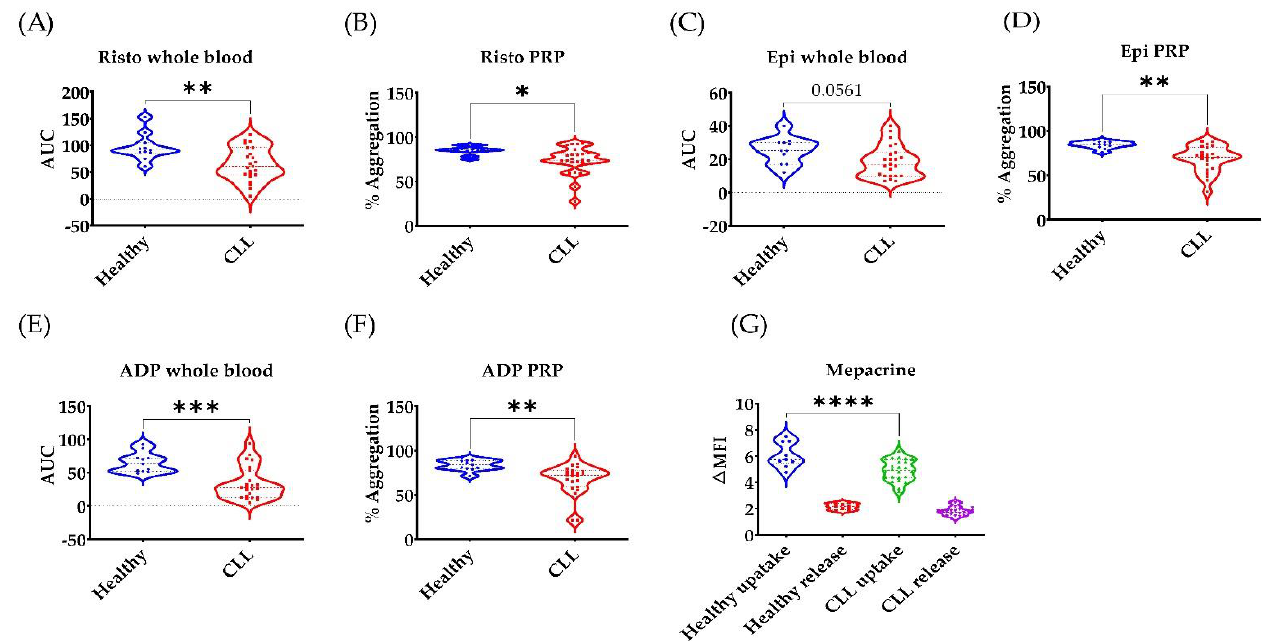
Figure 2. Broad reduction in CLL platelet response to several agonists. ( A – F ) Impaired platelet response to ristocetin, epinphrine and ADP in whole blood and PRP. ( G ) Reduced mepacrine uptake in CLL platelets compared to health volunteers. * p < 0.05, ** p < 0.01, *** p < 0.001, **** p < 0.0001; n = 23 CLL patients and 11 age-matched healthy volunteers. Platelet aggregation in PRP was measured by LTA using ristocetin: 1.2 g/L, epinephrine: 7 µM, and ADP 4 µM. Whole blood aggregation was measured by MEA using risotcetin 0.7 g/L, ADP 6.4 µM and epinephrine 7 µM.